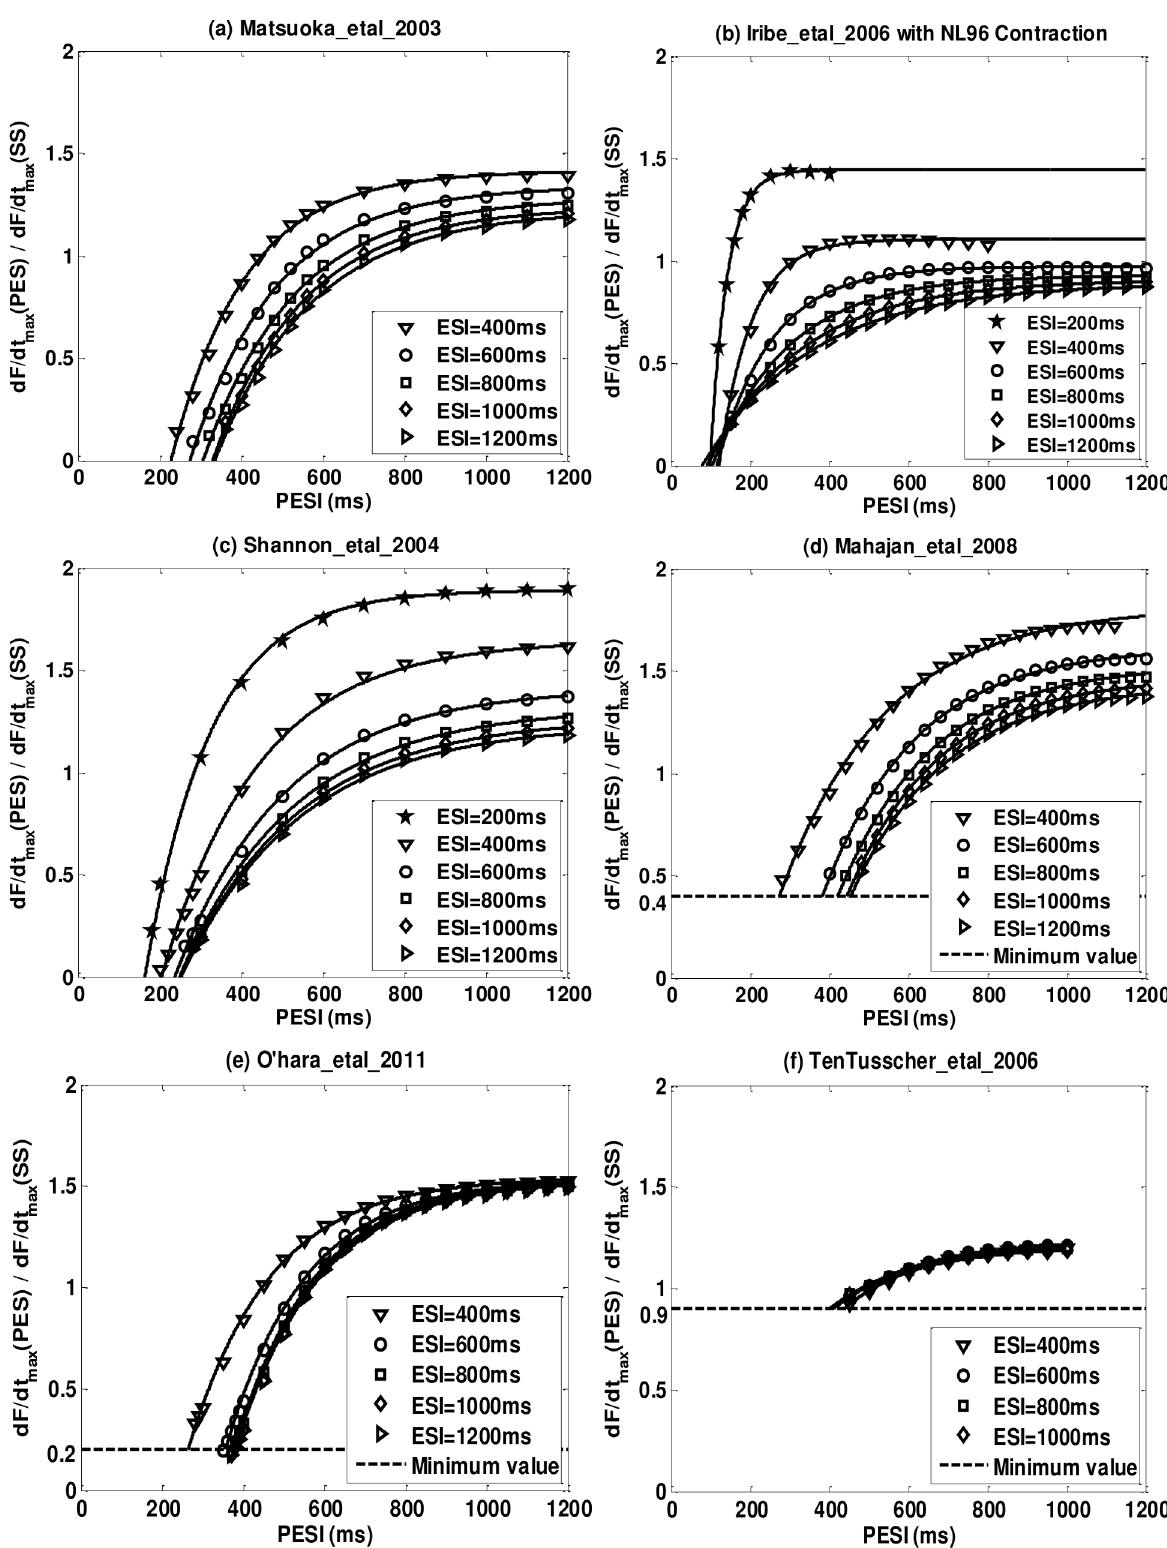
Fig 6. Representative postextrasystolic mechanical restitution curves ( MRC pes ) for six models after implementation of the NL96 contraction. (a) Matsuoka_etal_2003; (b) Iribe_etal_2006; (c) Shannon_etal_2004; (d) Mahajan_etal_2008; (e) O ’ hara_etal_2011; (f) TenTusscher_etal_2006.